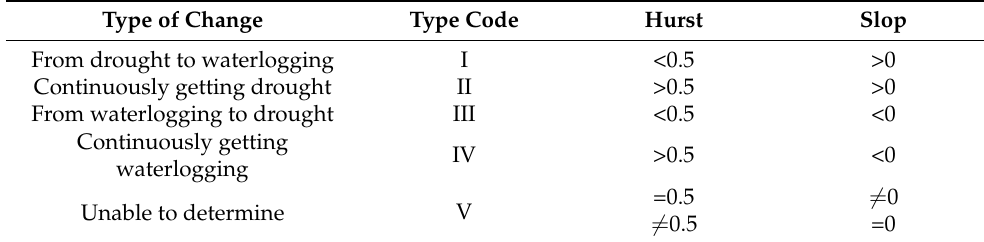
Table 4. The types of coupling of drought and